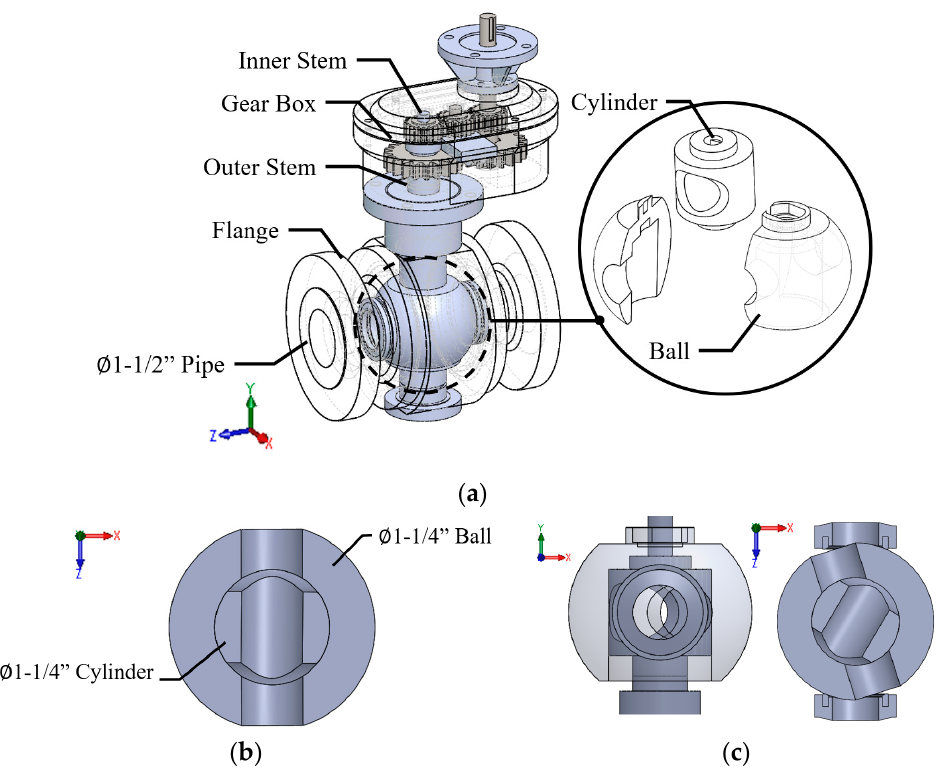
Figure 1. Configuration of the proposed cylinder-in-ball valve: ( a ) 3D model of the cylinder-in-ball valve; ( b ) perforated holes in the ball and cylinder; ( c ) coaxial counter-rotating motion of the cylinder and ball at an opening rate of 20%.